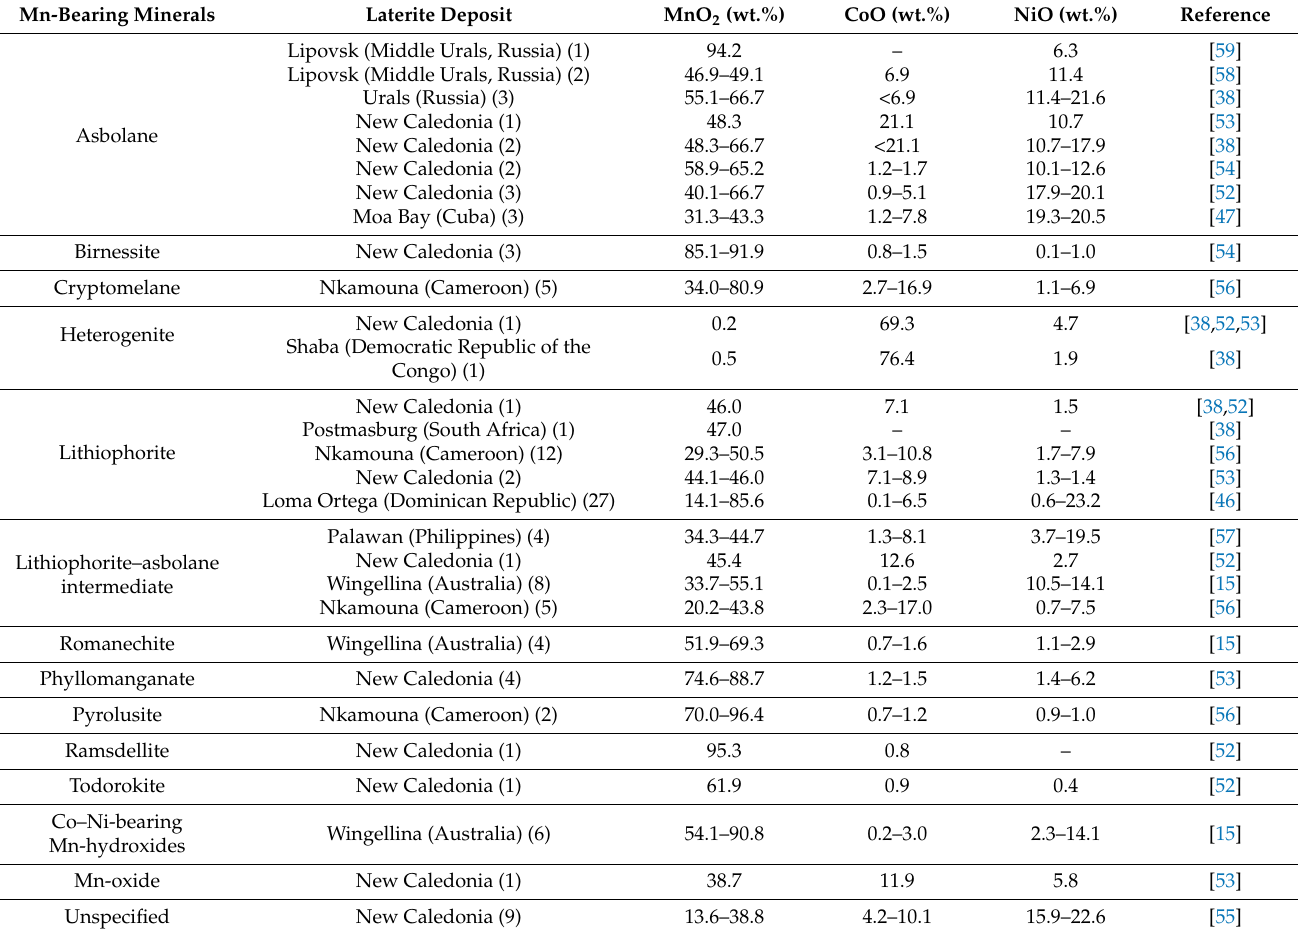
Table 4. Manganese, Co and Ni contents of Mn-bearing minerals from different laterite deposits (number of samples within